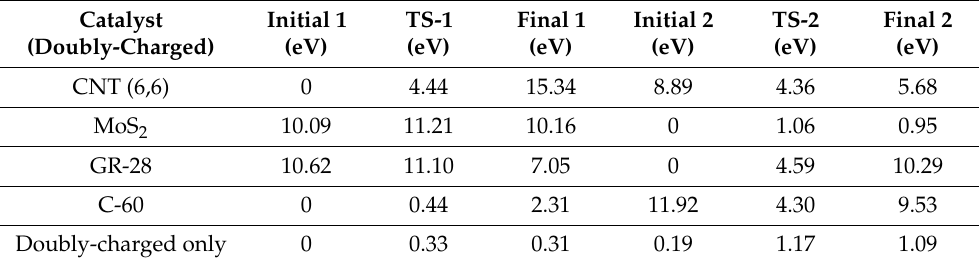
Table 2. Calculated relative initial, transition, and final states in electron-volts (eV) of step 1 and step 2 of the desulfurization redox reaction. The relative states have been calibrated to zero for the lowest calculated potentials that were found in step 1 “or” step 2 for armchair (6,6) carbon nanotube, molybdenum disulfide (MoS 2 ), graphene flake containing 28 atoms (GR-28), and fullerene (C-60) doubly-charged catalysts. The calculations performed without the assistance of a catalyst for ∆ TS-1 and ∆ TS-2 are presented as (doubly-charged only) for the introduction of 2e − .